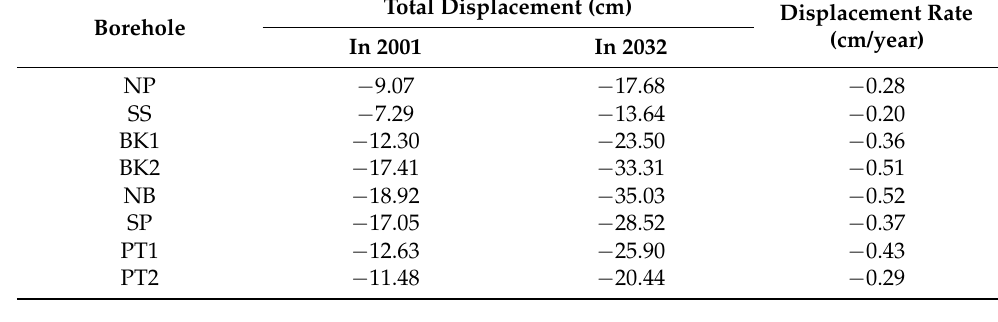
Table 4. Total displacement and displacement rate.